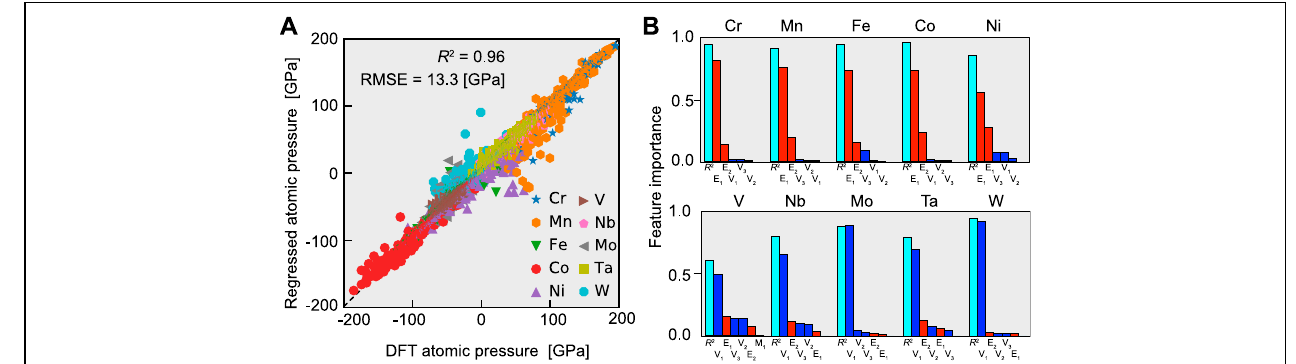
FIGURE 6 | Regression results for the atomic hydrostatic pressure by the random forest method with the features listed in Table 3 . (A) Comparison of the regressed pressure and that obtained by the DFT calculations. The data for all of the constituent elements were regressed at the same time. (B) Importance of features obtained by the random forest method. Here, the regression was performed individually for each element.